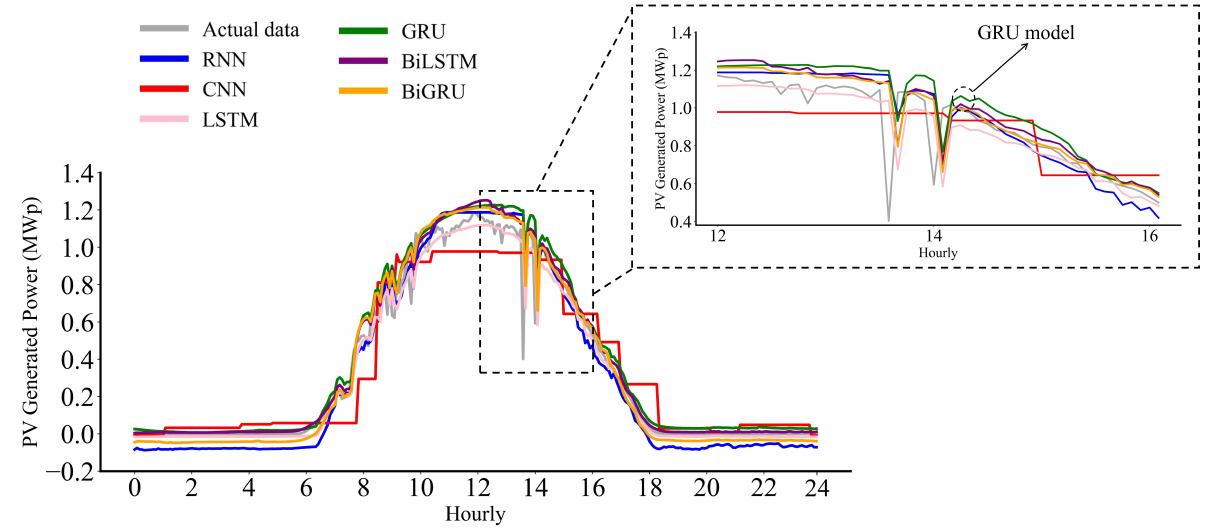
Figure 6. One-day PV generation forecasting on a regular weather day obtained by a single model and compared with actual PV generation data. The inset figure shows the forecasting performance of the single model between 12 and 16 h. In the single deep learning model, the most preferable model for the short-term prediction of the PV power generation on a regular weather day is the GRU